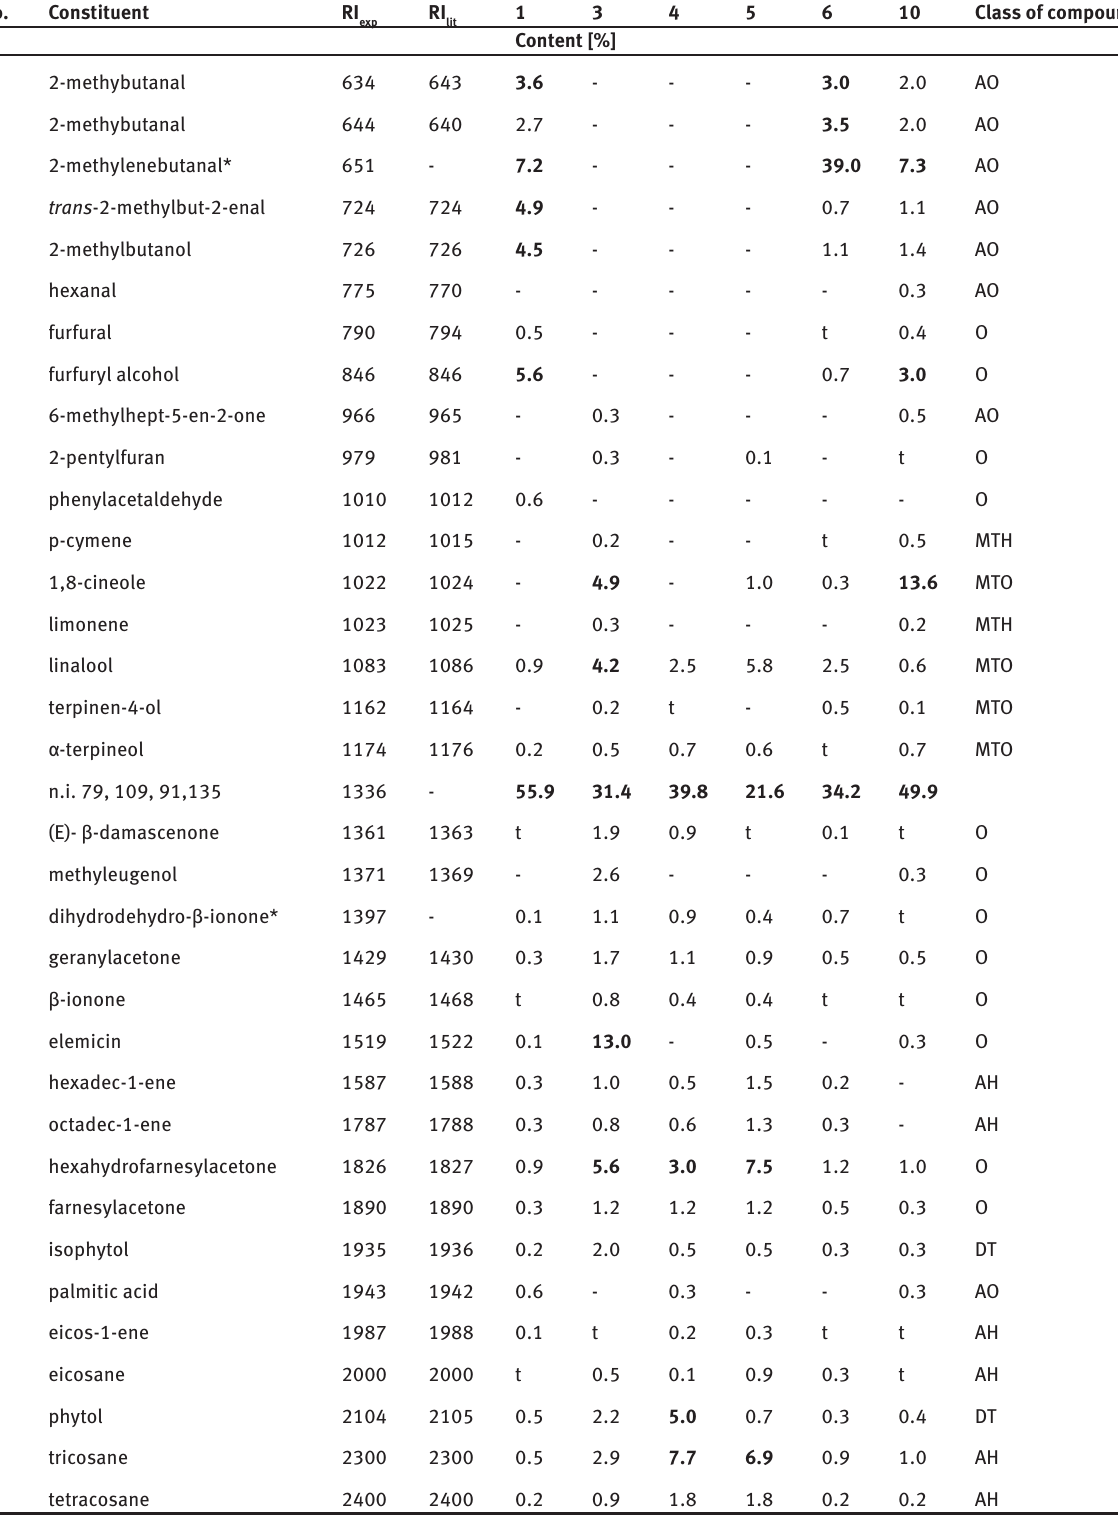
Table 3: Composition of essentials oils of Hemerocallis cultivars aerial parts: 1 – H. ‘Rebel Cause’; 3 – H. ‘Catherine Woodbuery’; 4 – H. fulva ; 5 – H. ‘Chicago Apache’; 6 – H. ‘Danuta’; 10 – H. ‘Aten’. RI value less than 0.05%; n.i., not identified; *tentatively identified according to